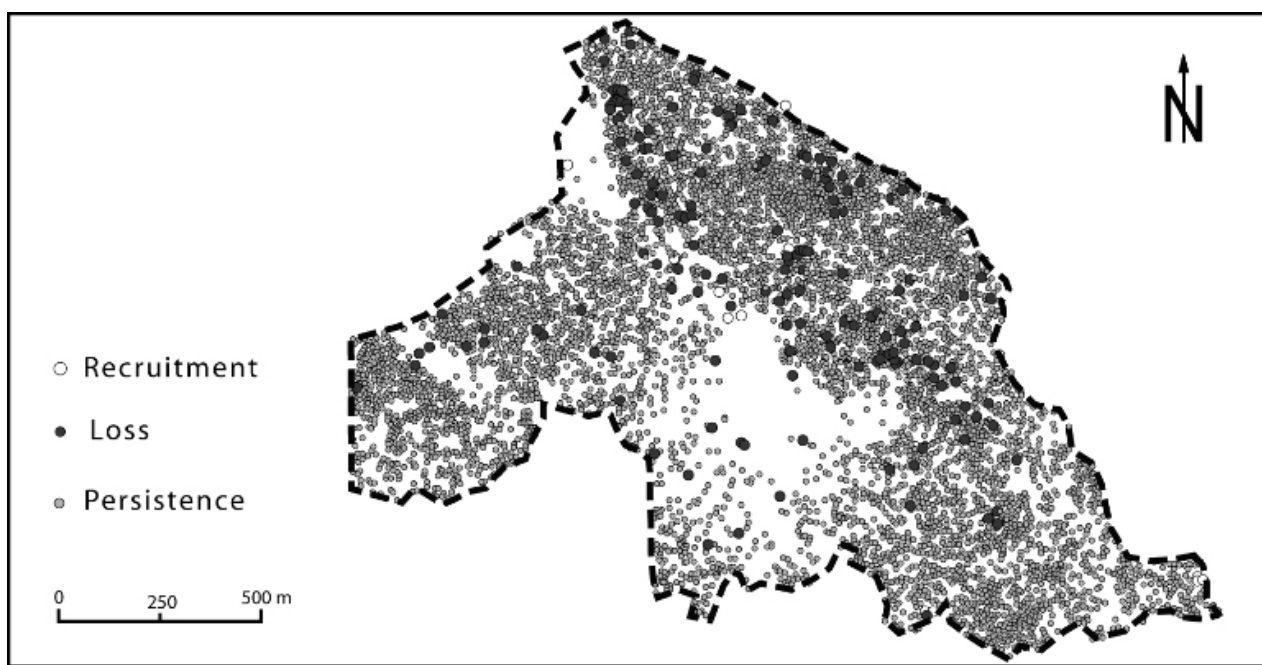
Fig. 4 . Spatial distribution of outlived, lost, and recruited trees at the Dehesa Boyal site,